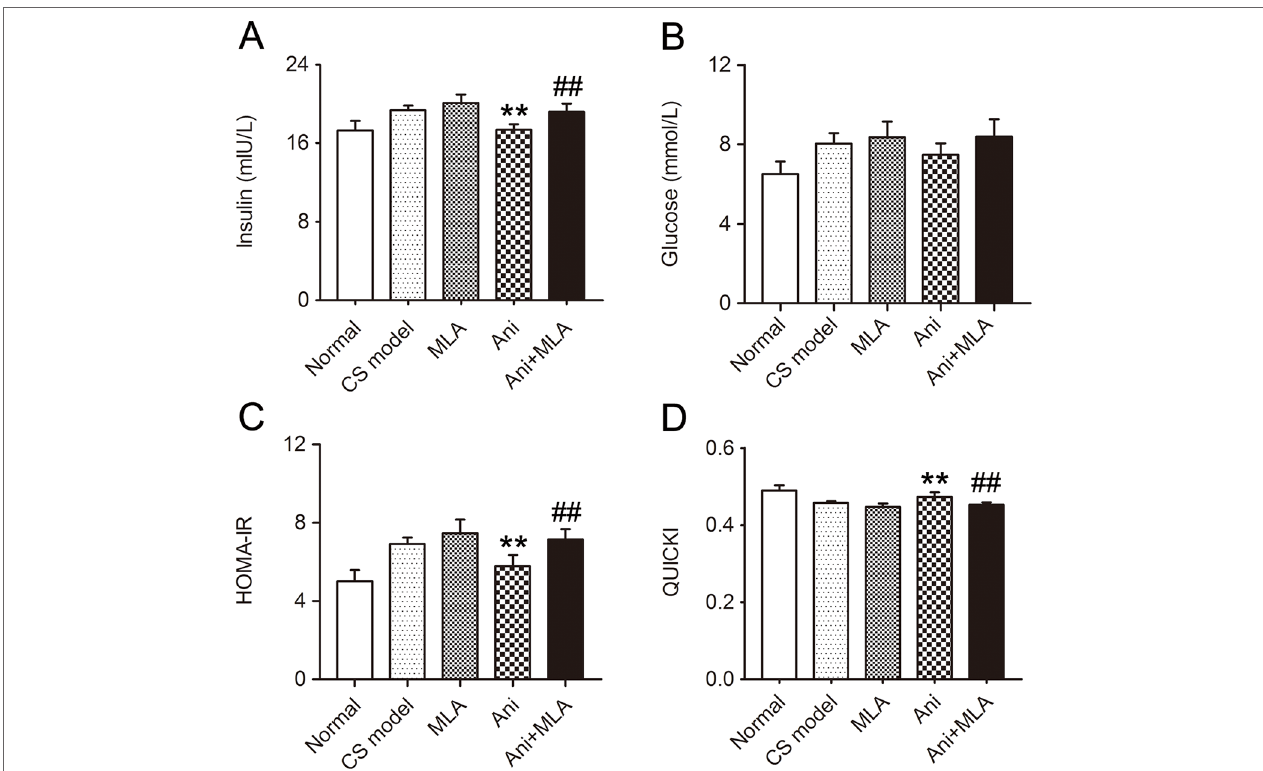
FIgURE 5 | Anisodamine (Ani) increases insulin sensitivity in male mice with crush syndrome (CS). Ani (28 mg/kg, i.p.) was administrated at 30 min before decompression in mice with CS, and methyllycaconitine (MLA) (10 mg/kg, i.p.) was given 30 min earlier. Blood samples were collected at 6 h after decompression. Ani reduced serum